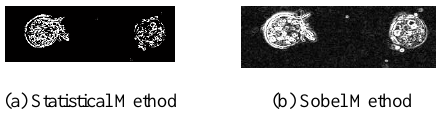
FIGURE 2: Edge detection